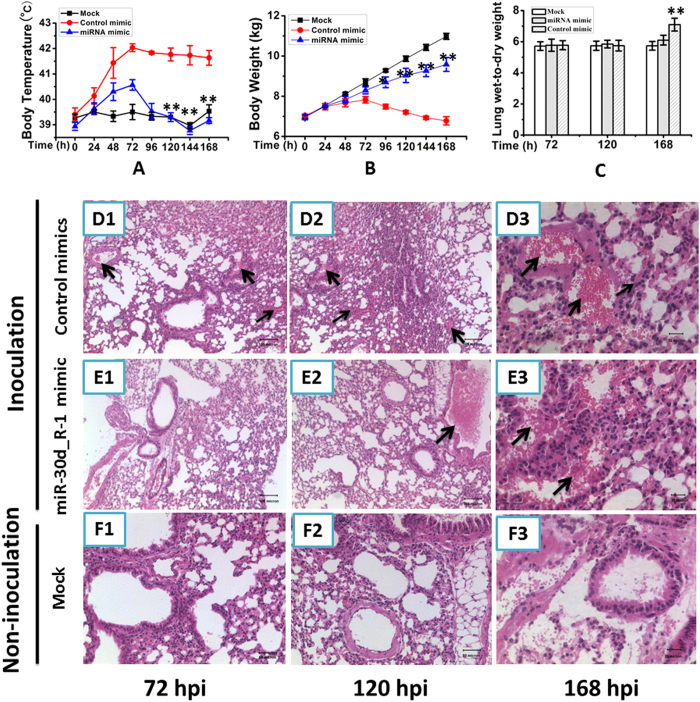
ssc-miR-30d_R-1 suppressed the pathogenic effect of PRRSV in SPF piglets.The piglets were treated with PBS, control mimic and synthetic ssc-miR-30d_R-1 mimic before being inoculated with PRRSV. The body temperature (A) and body weight (B) were measured at every time point. At 72, 120 or 168 h post inoculation, the piglets were sacrificed, and lung tissue was obtained to calculate the lung wet:dry weight ratio (C) and measure the pathological changes in the lungs (D–F, inflammatory cells infiltration: solid and thick arrows and hyperemia: solid and thin arrows). *P < 0.05; **P < 0.01. All values are expressed as the mean ± SD. P values were determined using a Student’s t test by comparing to the virus only group.